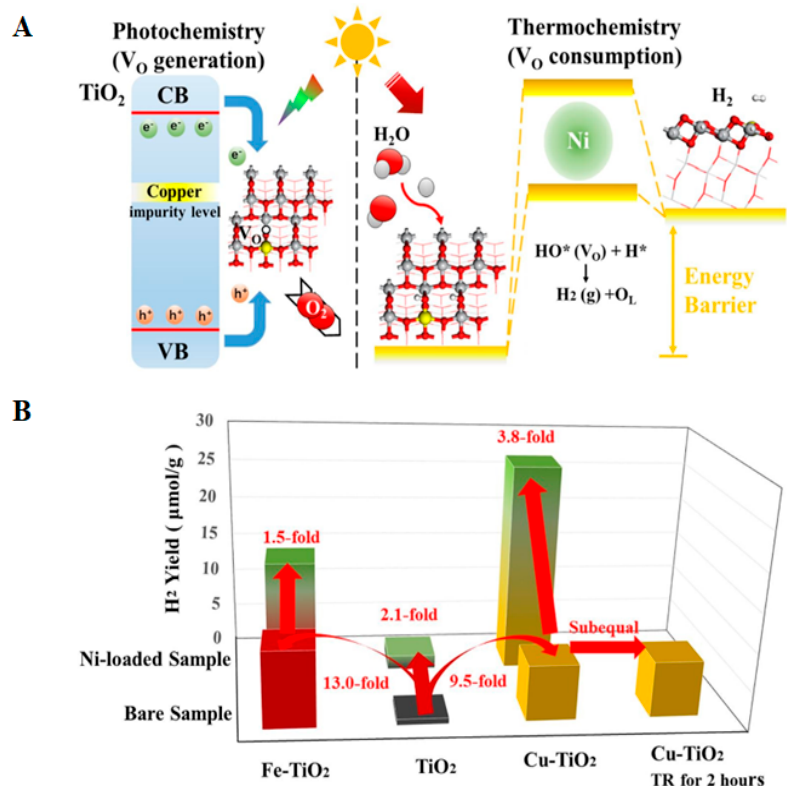
Figure 16. ( A ) Schematic of the reaction mechanism for photochemical and thermochemical processes. ( B ) The average H 2 yield of different catalysts. TR represented “thermochemical reaction”. Reprinted with permission from Ref. [165], copyright 2021, Elsevier.